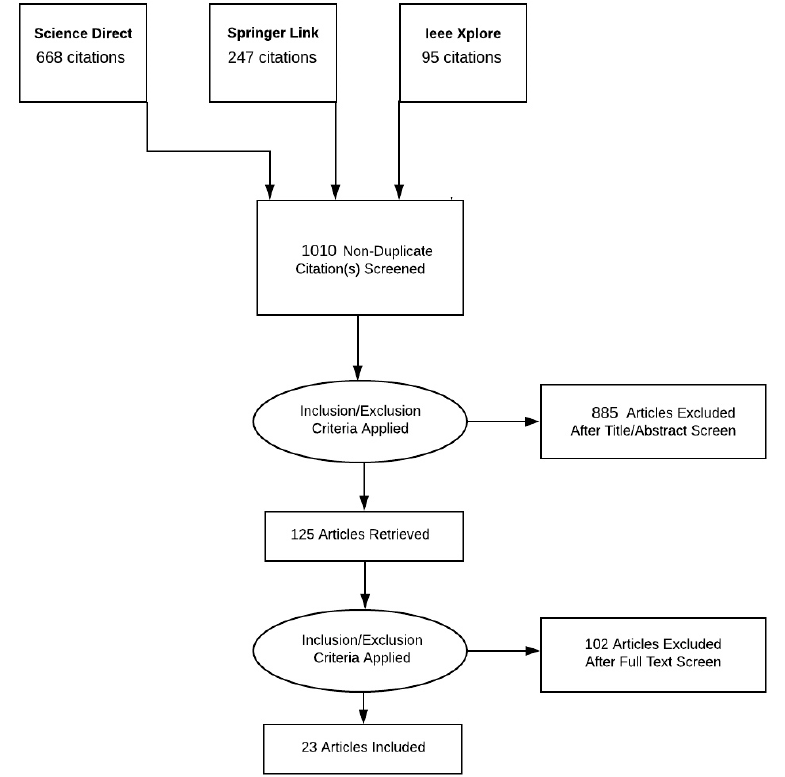
Figure 1. Application of PRISMA methodology.